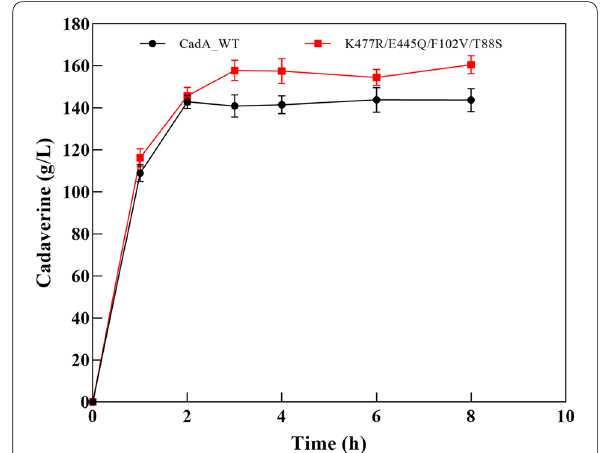
Fig. 9 Cadaverine production by whole-cell catalyst of the wild-type and mutant CadA. The reaction was conducted using 2.0 M lysine hydrochloride as the substrate and at an initial pH of 6.0 and 50 ºC, and the pH was not regulated during the reaction. The error bars represent standard deviations calculated from triplicate